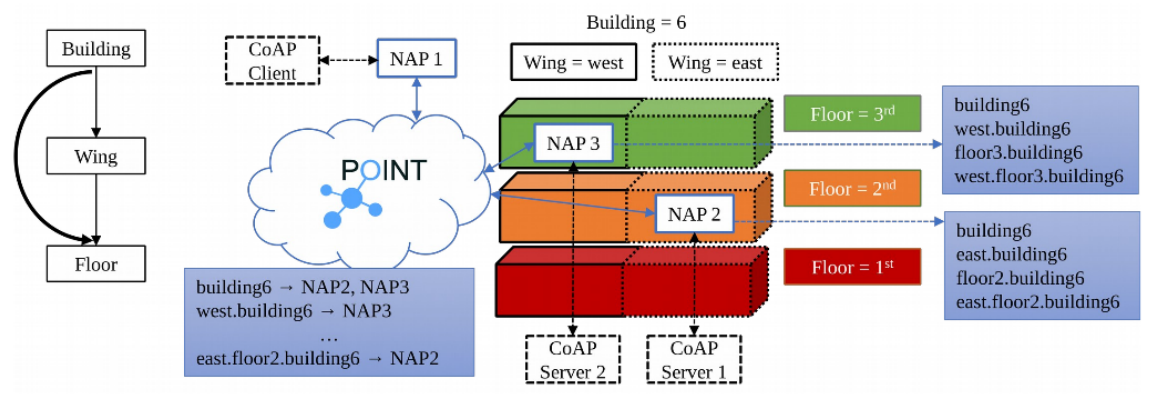
Figure 7. An overview of the group